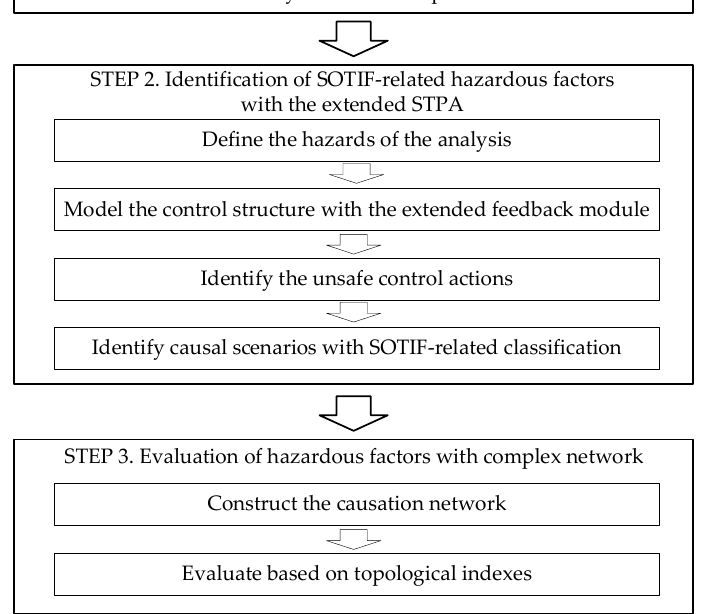
Figure 1. The framework of the approach proposed in this paper.